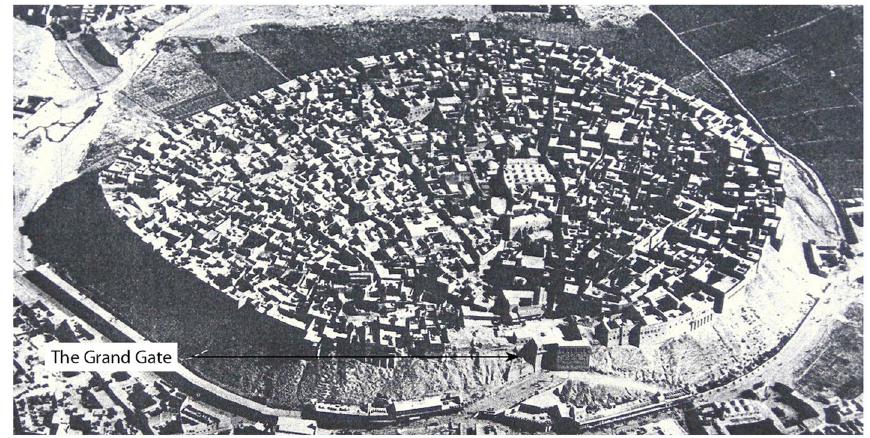
Fig. 2 The grand gate dominates the relationship between the urban context of the Suq and the Citadel, an aerial image for the site in 1951 (Source: Brammah 2009a,